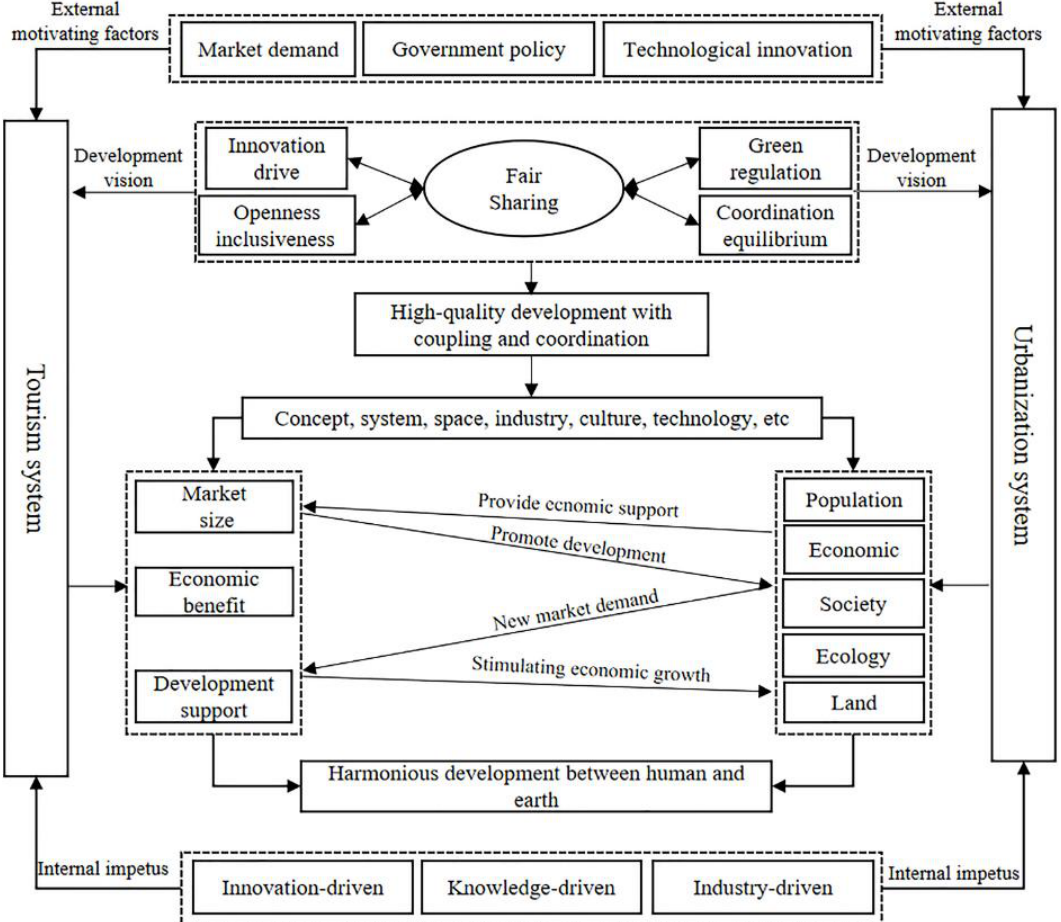
Figure 6. Mechanism of coupling and coordination of tourism industry and urbanization.